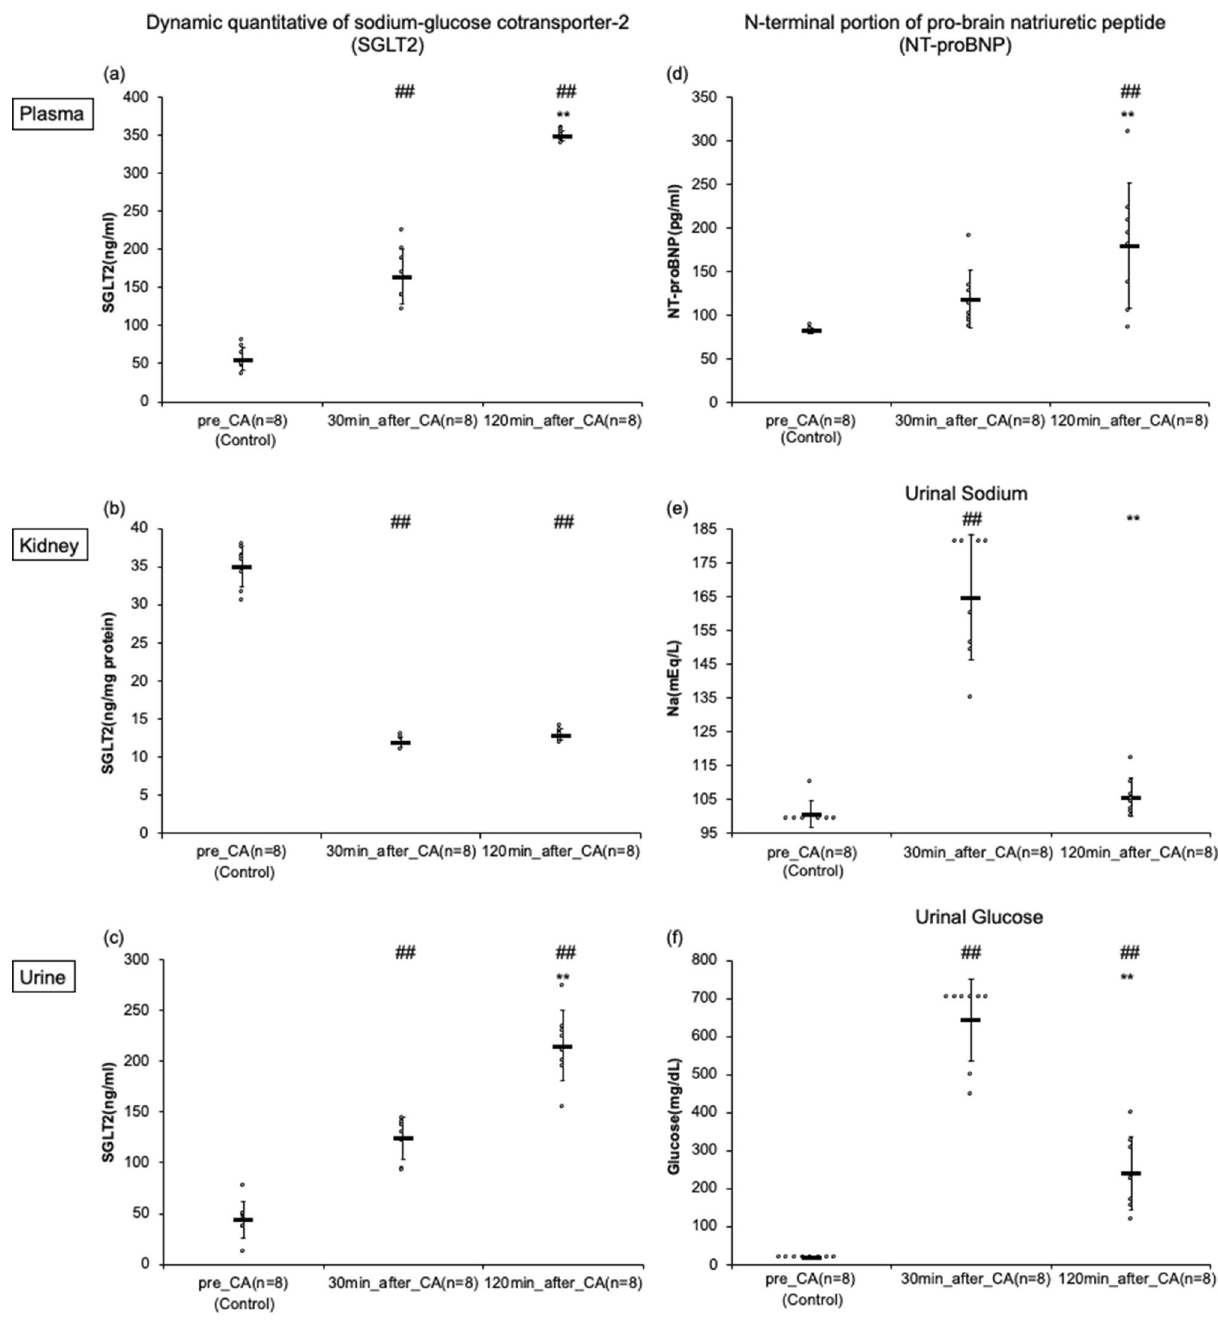
Figure 5. ( a )–( d ) Dynamic quantitative measures of sodium-glucose cotransporter-2 (SGLT2) of the kidney, plasma, and urine, N-terminal portion of pro-brain natriuretic peptide (NT-proBNP) of plasma by enzyme- linked immunosorbent assay in asphyxial cardiac arrest (CA) rats. ( a ) This shows the results of the plasma. ## p < 0.01 compared with the pre-CA group. ** p < 0.01 compared with 30 min post-CA group. ( b ) This demonstrates the results of the kidney. ## p < 0.01 compared with the pre-CA group. ** p < 0.01 compared with 30 min post-CA group. ( c ) This indicates the urine results. ## p < 0.01 compared with the pre-CA group. ** p < 0.01 compared with 30 min post-CA group. ( d ) This shows the results of plasma as mean ± SD. ## p < 0.01 compared with the pre-CA group. ** p < 0.01 compared with 30 min post-CA group. ( e )–( f ) Dynamic quantitative measures of sodium and glucose levels in the urine. ( e ) This shows the result of urine sodium. ## p < 0.01 compared with the pre-CA group. ** p < 0.01 compared with 30 min post-CA group. ( f ) This shows the result of urine glucose. ## p < 0.01 compared with the pre-CA group. ** p < 0.01 compared with 30 min post-CA group. Numbers are expressed as mean ±